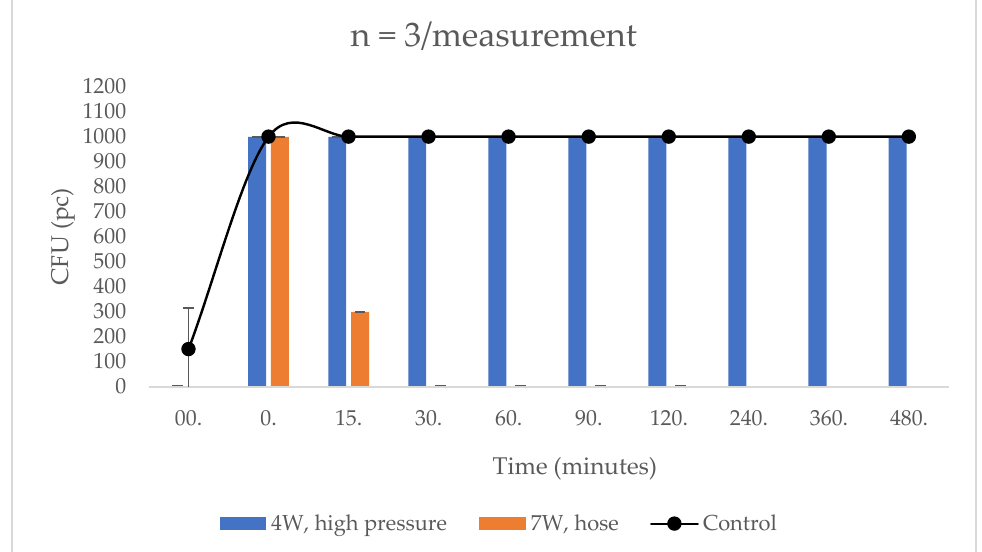
Figure 3. Washing test on the treated and untreated surfaces from a distance of 300 cm. In the case of normal water jet washing, the paint-treated area had only 300 CFU at minute 15, which further decreased to 1 CFU by minute 30, and by minute 120, the bacterial count reduction was 100%. After washing with high pressure equipment, there was no CFU reduction in samples taken from the treated surface even after 480 min.